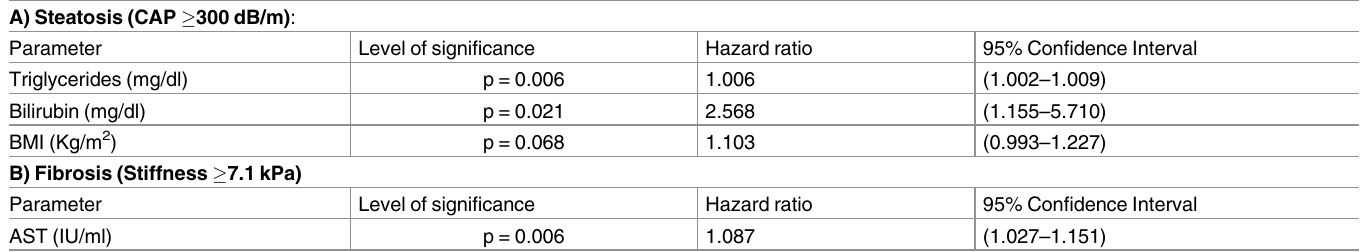
Table 4. Parameters entering the final regression